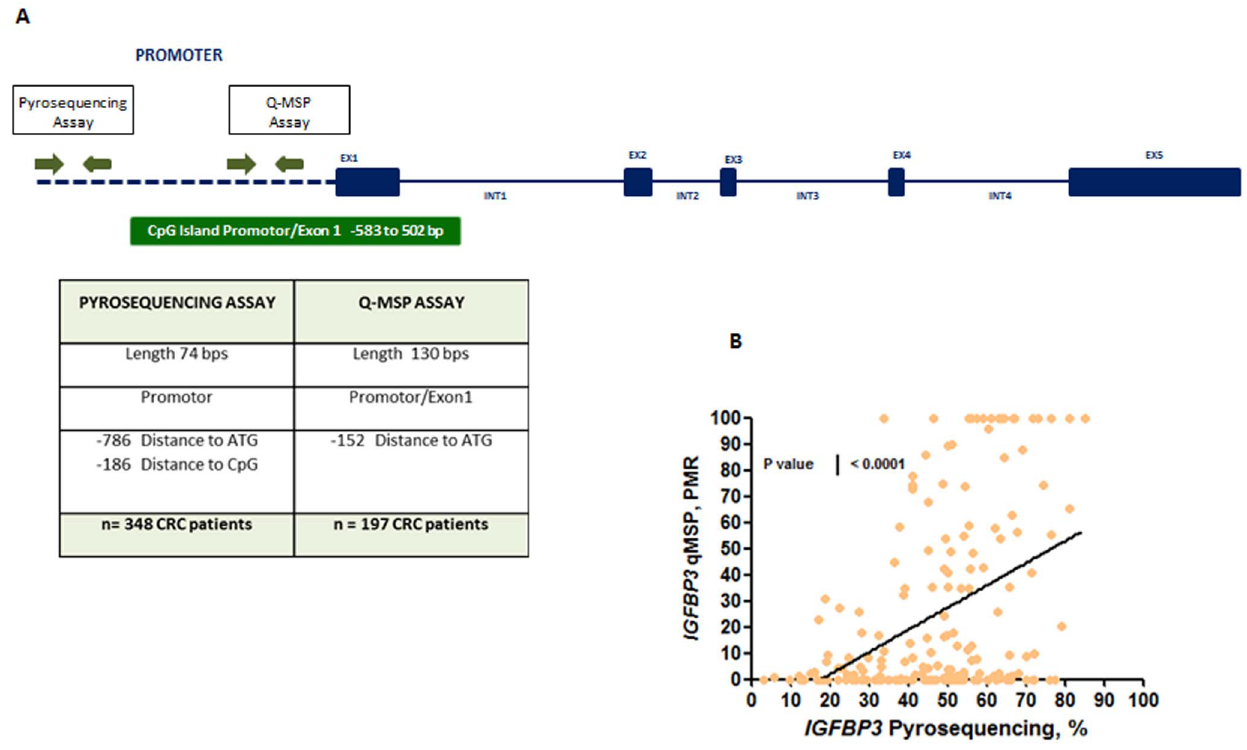
Figure 6. Comparison between methylation levels within igfbp3 promoter in crc tissues. (a) Schematic overview of the insulin-like grown factor binding protein 3 (igfbp3) gene. exons are represented by blue boxes, introns with blue lines, and the promoter region by blue dashed lines. the igfbp3 gene has one cytosine-phosphate-guanine (cpg) island at in the promoter region and exon1 underscoring the potential of modulating gene expression by means of cpg hypermethylation, and this is represented by a green box. we performed two different assays covering both cpgs islands (indicated by green arrows) using two quantitative methods: pyrosequencing and qmsp in order to correlate methylation levels of these two locations. (b) Linear regression analysis comparing igfbp3 methylation levels by pyrosequencing (% methylation) in 348 patient samples and qmsp (pmr) assays in crc tissues (n=197).